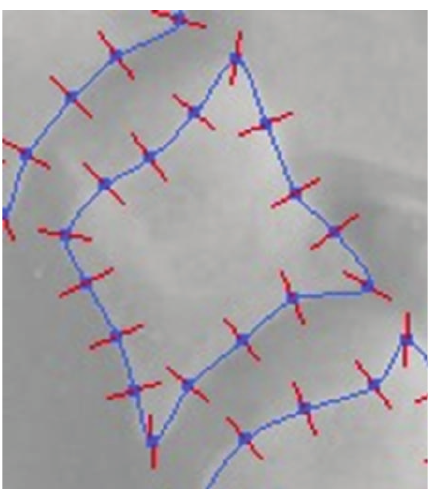
Figure 10: Normal of the contours at each point of the